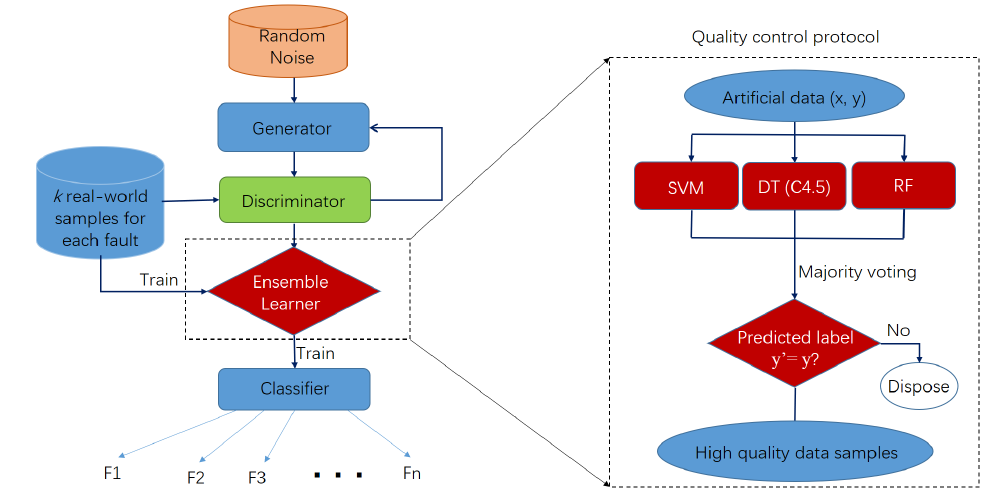
Figure 3. Proposed framework for AHU fault diagnosis based on Wasserstein GAN (WGAN) and support vector machine